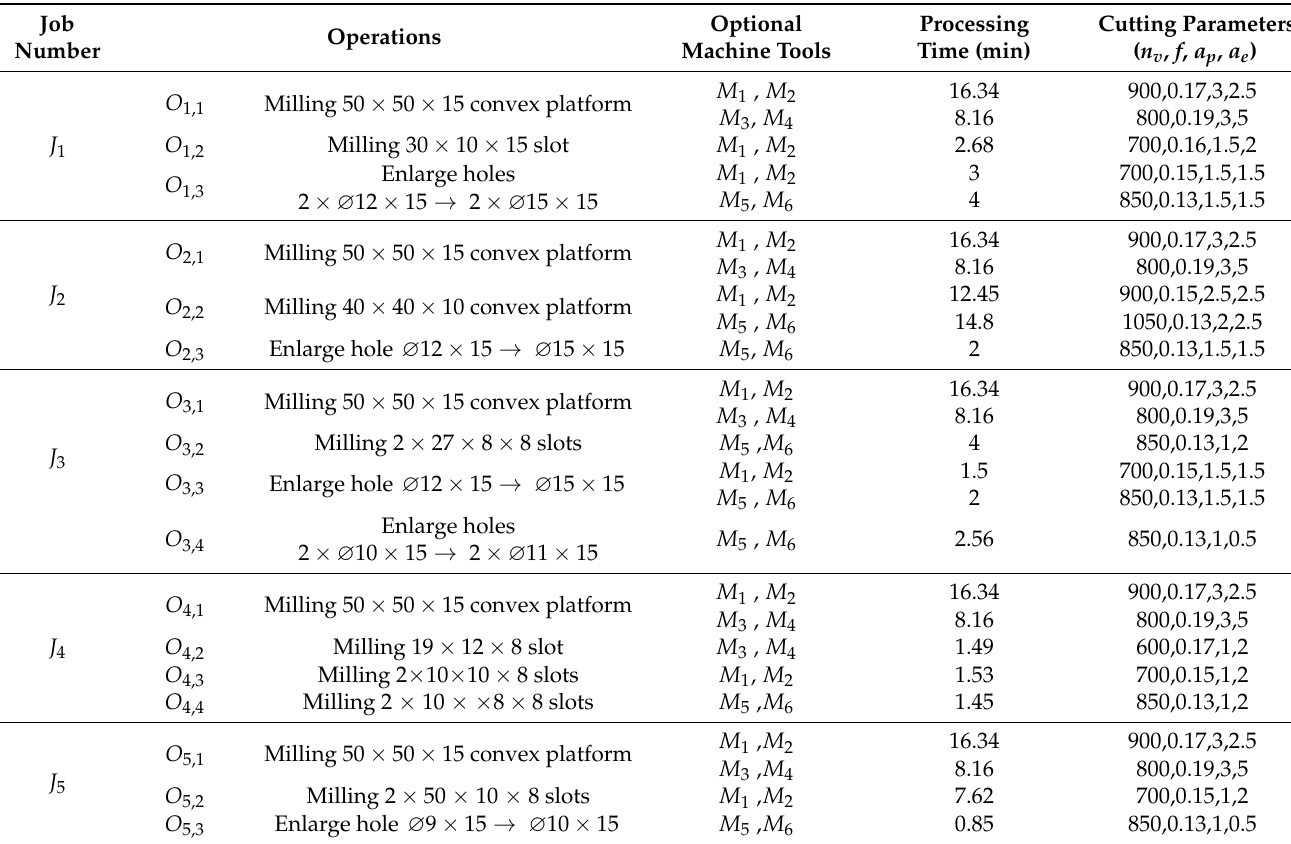
Table 6. Workpiece information.